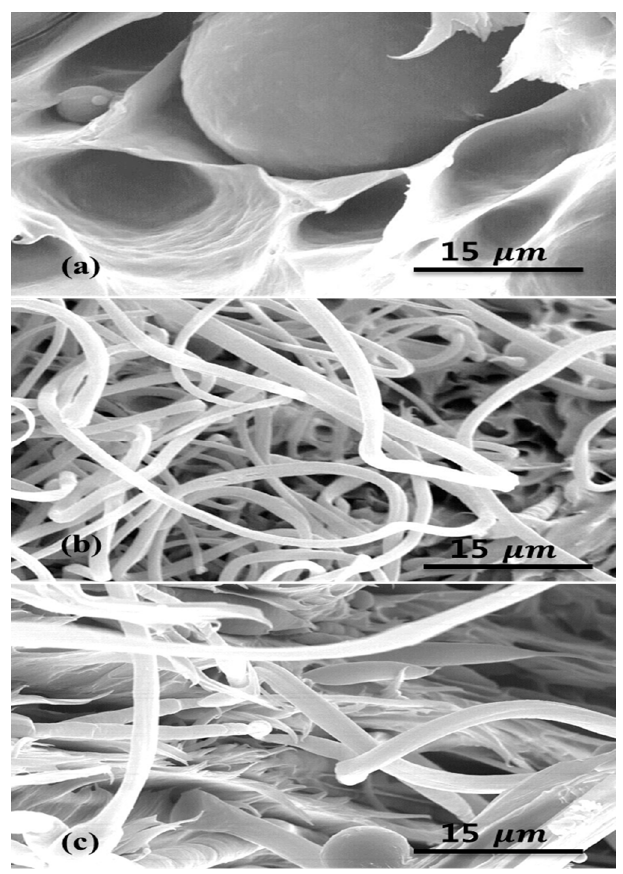
Figure 2. SEM images of the tensile fractured surfaces of PA6/PP (80/20) blends irradiated at 0 kGy ( a ); 20 kGy ( b ); and 200 kGy ( c ).